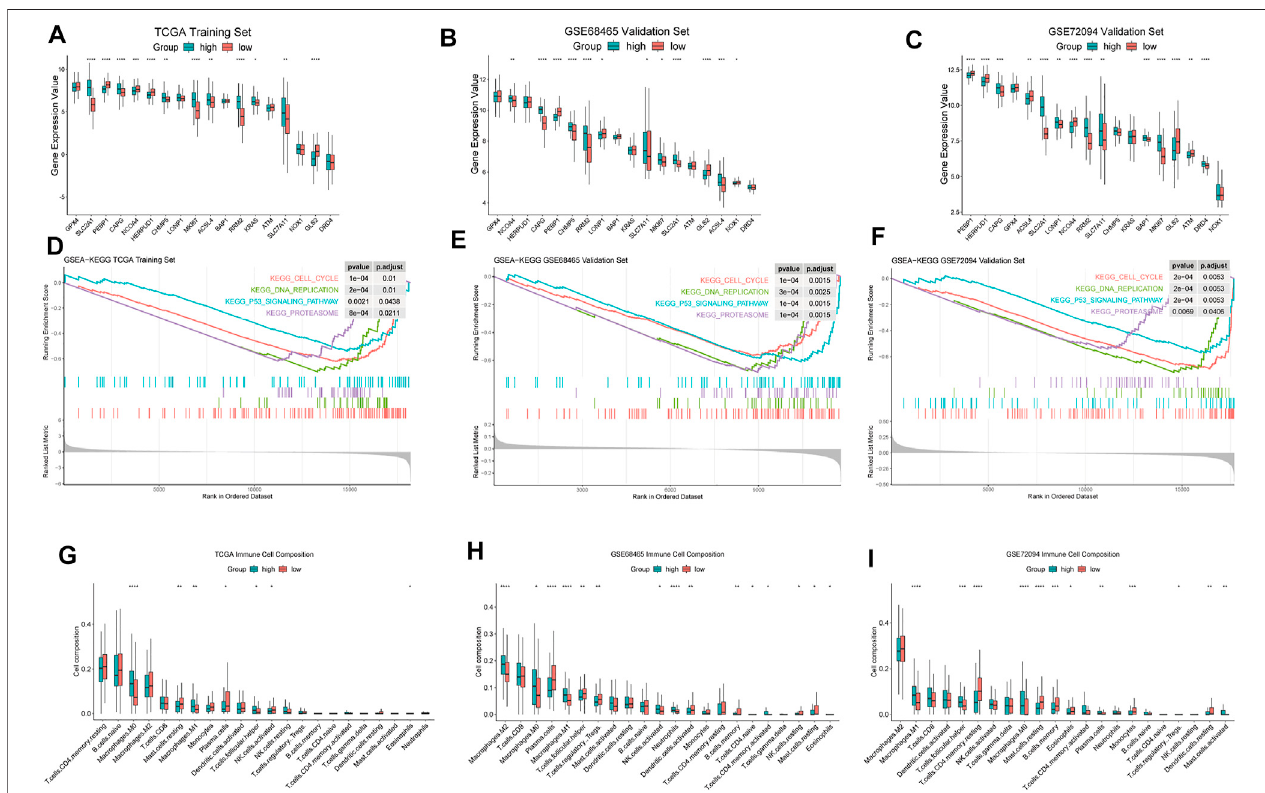
FIGURE 4 | Differences of biological characteristics between high- and low-FRGPI groups. We used the following convention for symbols indicating statistical signi fi cance: *: p < 0.05 , **: p < 0.01 , ***: p < 0.001 , and ****: p < 0.0001 . (A – C) ferroptosis-related genes and MKI67 for the expression level comparisons in the three cohorts. (D – F) Enriched GSEA – KEGG pathways in the three cohorts. (G – I) In fi ltration levels of 22 kinds of immune cells in the three